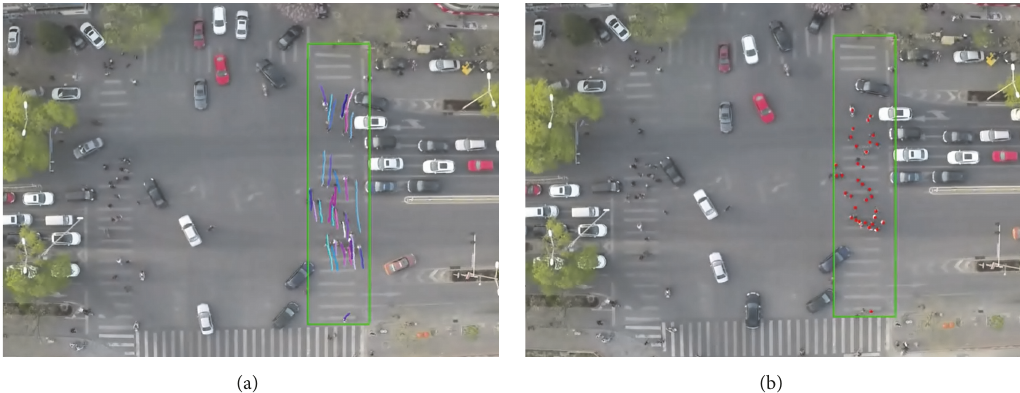
Figure 4: (a) Tracking trajectory visualization and (b) tracking point